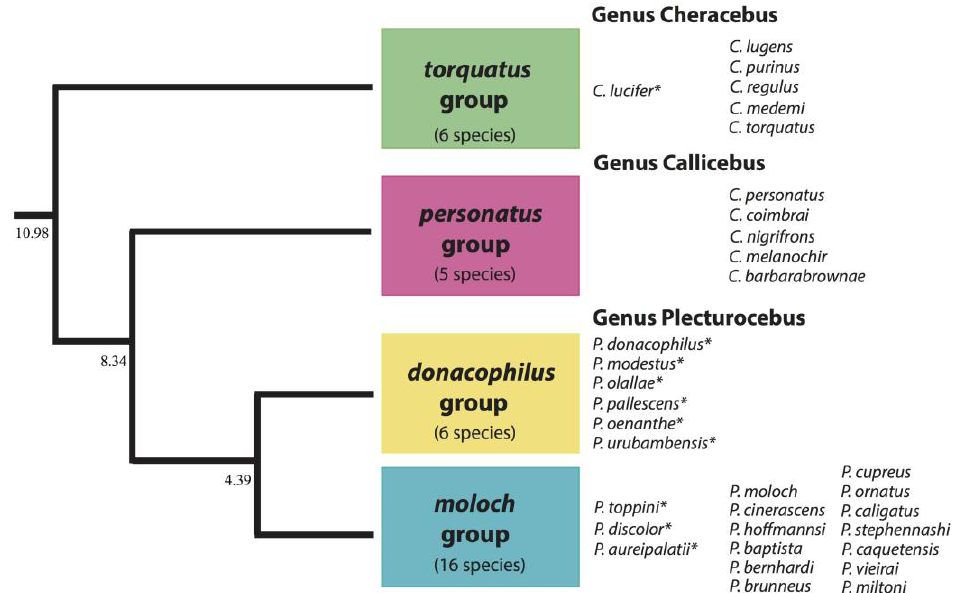
Figure 1. Phylogenetic reconstruction based on mitochondrial, nuclear, and combined datasets of high quality DNA showing the divergent times (mean age in Ma) of the four clades of titi monkeys. Shown at right is the current taxonomy at the genus level and with 33 species. Asterisks denote the ten species of titis investigated in the present study. Adapted from Byrne et al. [62].